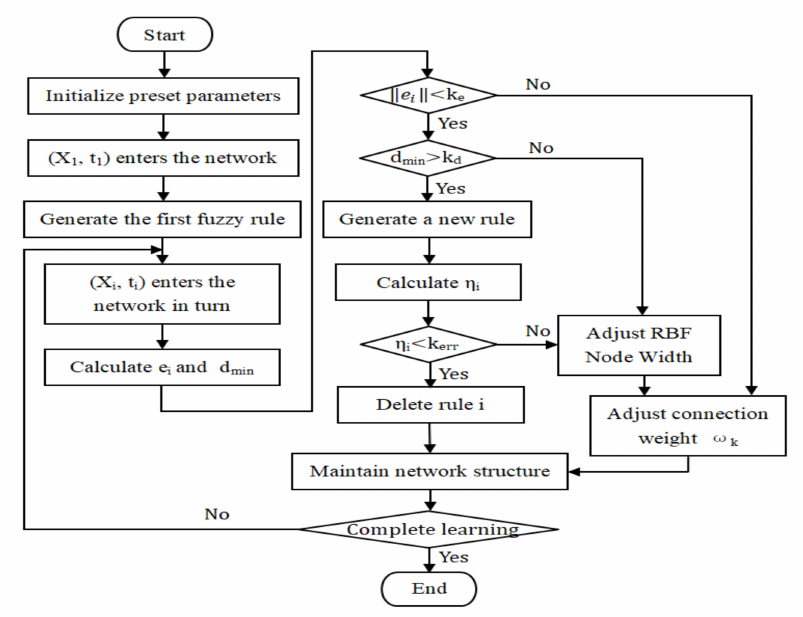
Figure 4. Flow of ANFM learning algorithm.